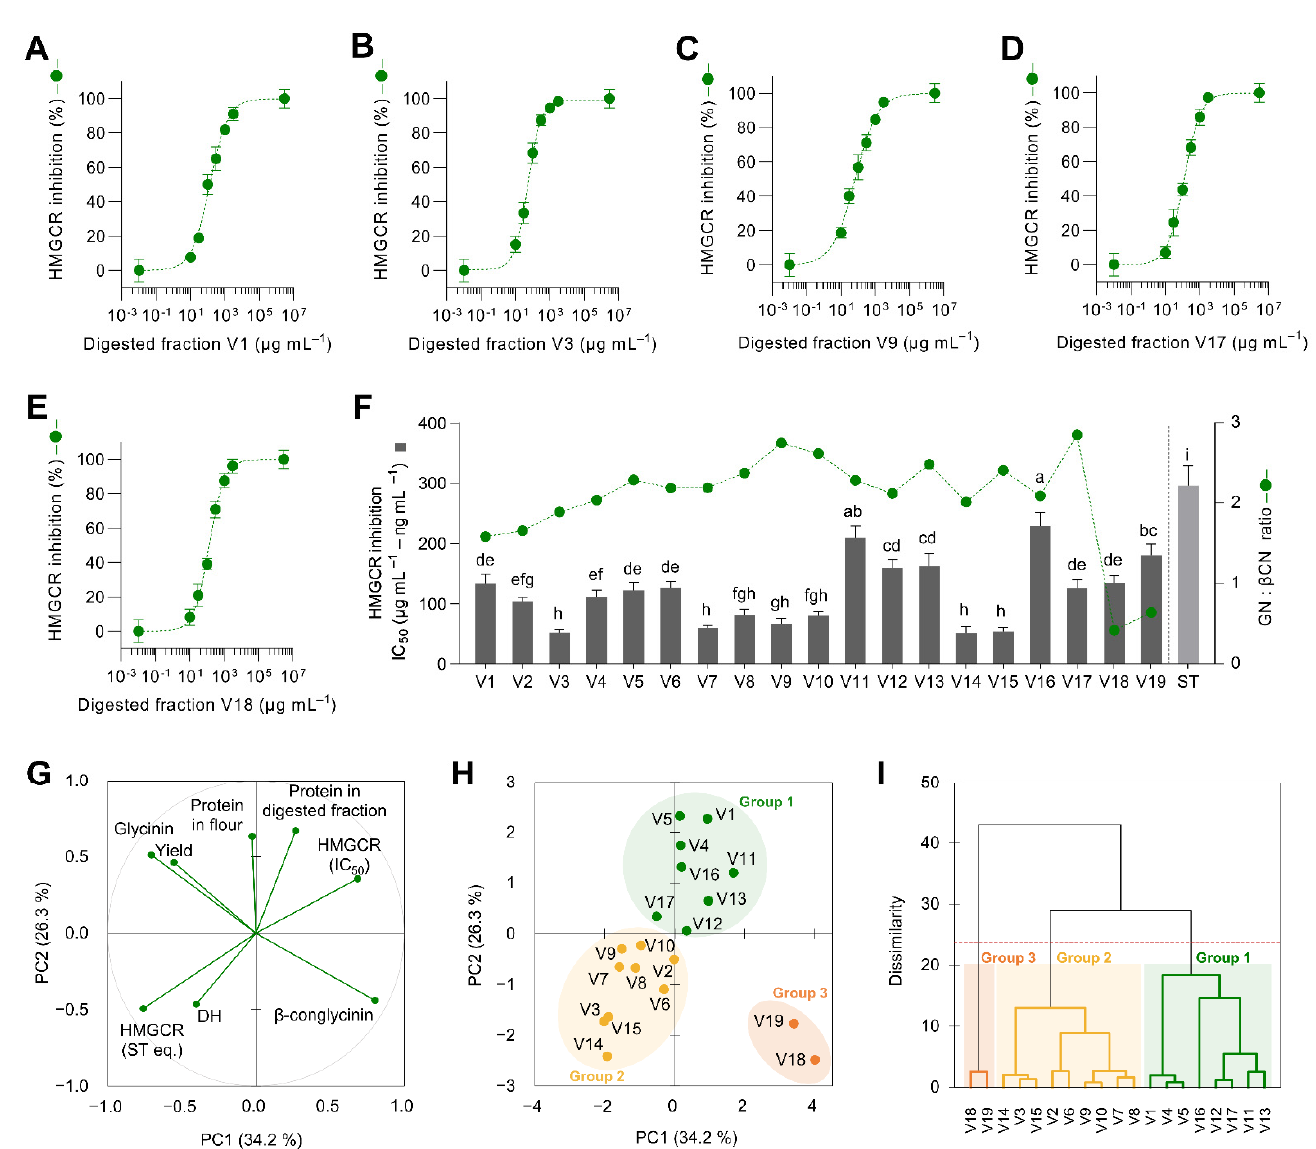
Figure 2. Dose–response curves of the 3-hydroxy-3-methylglutaryl-CoA reductase (HMGCR) in- hibitory effect of different soybean varieties digested under gastrointestinal conditions (V1: ( A